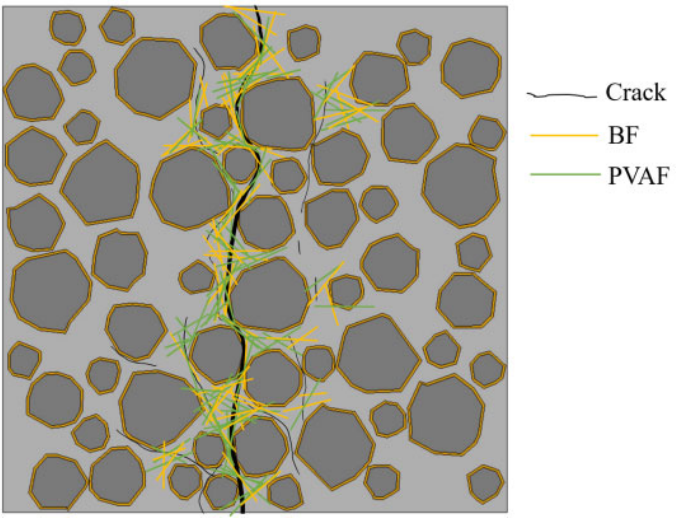
Figure 15. Effect mechanism of hybrid fibers on splitting tensile properties of concrete (only fibers at cracks are shown).